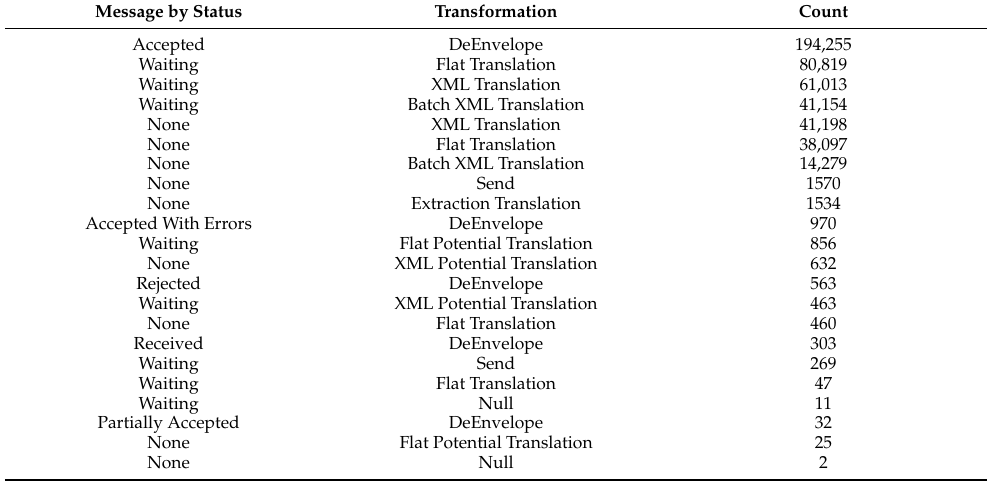
Table 22. Messages by ack status and